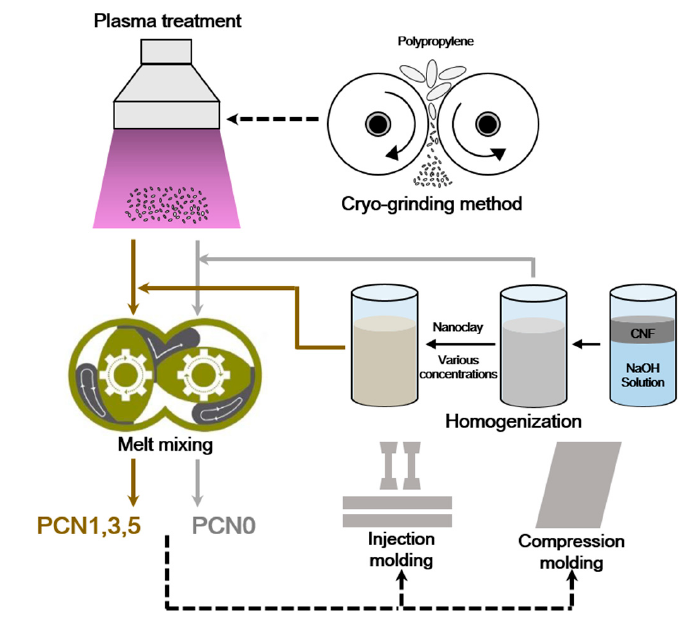
Figure 1. Schematic illustration of PP / CNF and PP / CNF / nanoclay nanocomposites